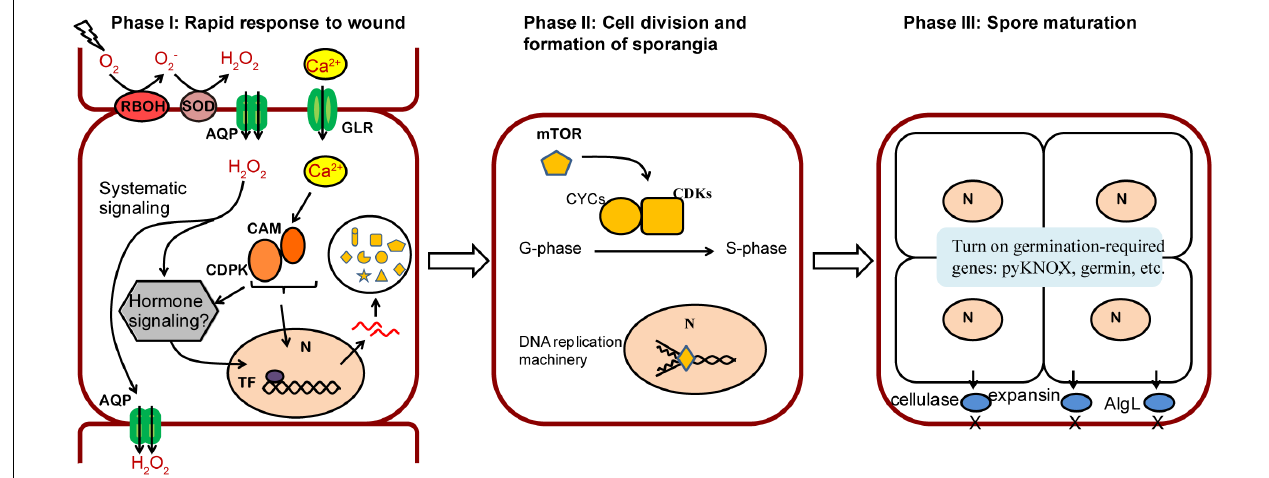
FIGURE 6 | A proposed model of three phases in wound-induced cell fate reprogramming in N. yezoensis . Systematic signaling of ROS coupled with the Ca 2 + -dependent signaling triggers an initial response to wound stress in Phase I, including activation of CAM/CDPK for downstream transcriptional regulation and possible phytohormone-related regulation yet to be determined. The induced expression of mTOR functions as a master regulator in turning on cell cycle progression by regulating multiple cyclins and CDKs (Phase II). Once cell divisions complete, sporangia containing 2–4 pre-spores are formed. Proteins required for spore release and germination accumulate in Phase